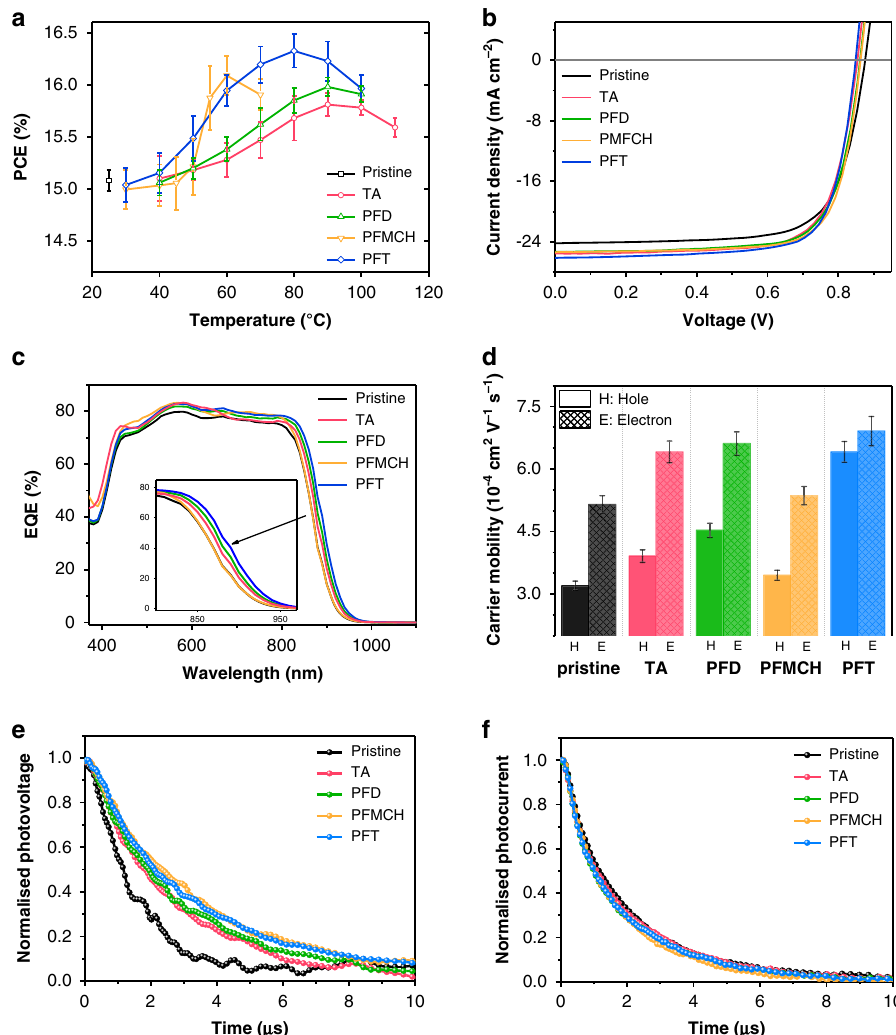
Fig. 2 Photovoltaic parameters and charge carriers dynamics. a PCE versus temperature of post-treatments. Error bars represent one standard deviation from the mean ( n = 20). b J – V and c EQE curves of optimized devices. d Carrier mobilities measured in single carrier diodes by fi tting of SCLC model. Error bars represent one standard deviation from the mean ( n = 8). e TPV, and f TPC of devices with different post-treatments at the optimized